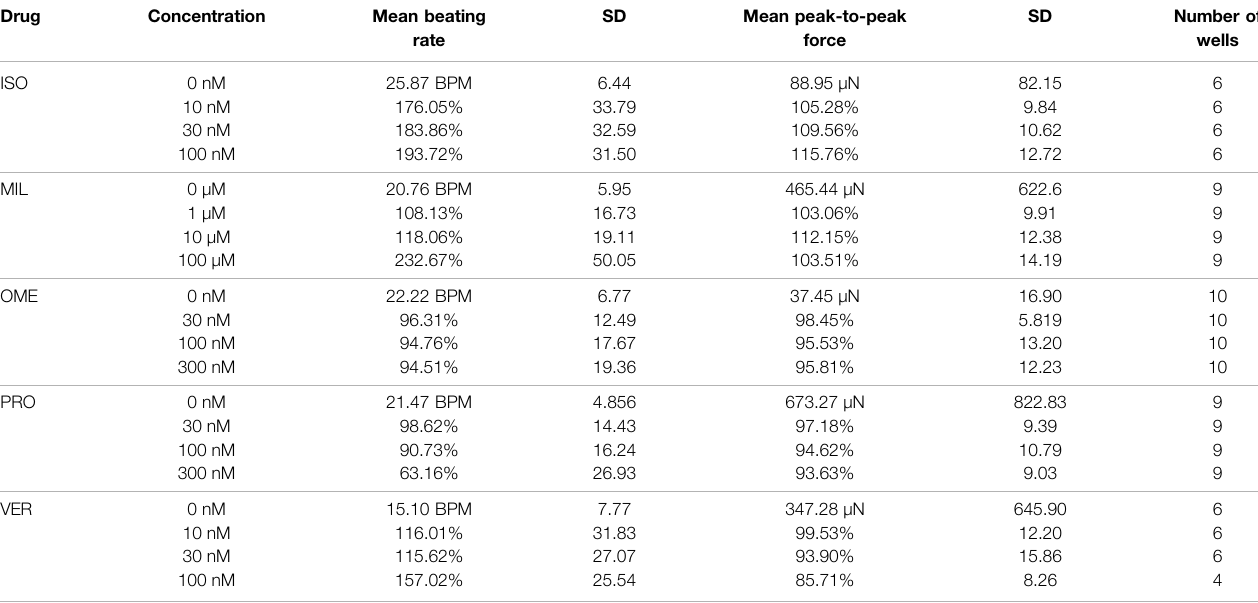
TABLE 1 | Mean beating rate and peak-to-peak force amplitudes from the baseline measurements and their percentage changes in the cumulative concentrations of the tested drugs normalized to the baseline measurements. Drug Concentration Mean beating SD Mean peak-to-peak rate